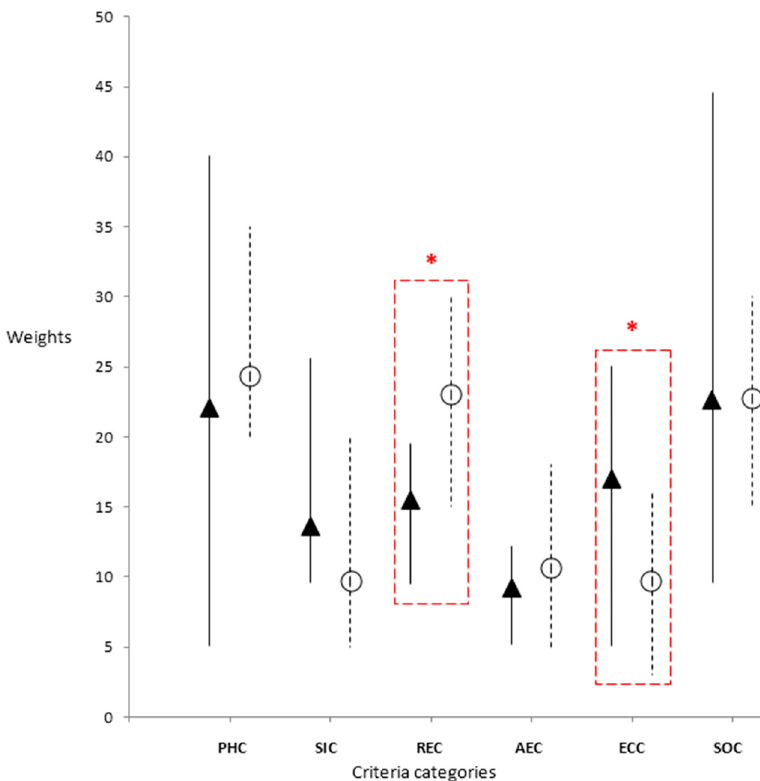
Figure 1. Average weighting of decision criteria categories by regions (Burkina Faso values are represented by black triangular markers with solid lines and Quebec values are represented by unfilled circular markers and dotted lines. The length of the lines indicates the range of weight values assigned by stakeholders). Criteria categories are shown along the X axis and average weights by category are shown along the y axis. Bars indicate the stakeholder assigned weight ranges for criteria categories. * The differences between the two groups (BF and QC) were found to be significant for the “Risk and Epidemiology” (REC) and “Economic” (ECC) categories only (unequal variance t -test, p < 0.5). Criteria category Legend: PHC: Public Health Criteria; SIC: Social Impact Criteria; REC: Risk and Epidemiology Criteria; AEC: Animal and Environmental Health Criteria; ECC: Economic Criteria; SOC: Strategic and Operational Criteria.